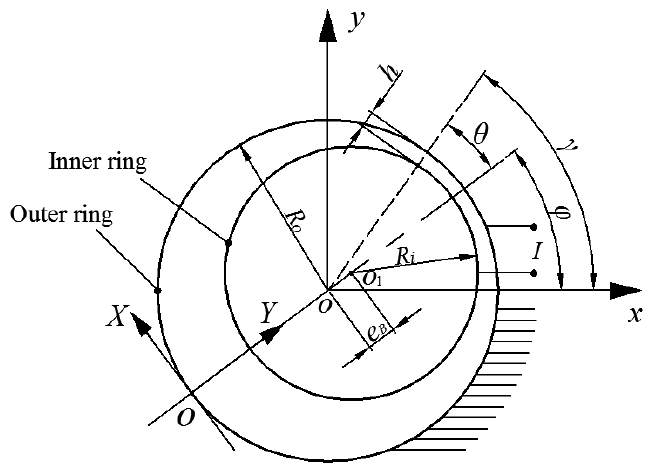
Figure 1. Schematic diagram of magnetorheological damper (MRD).